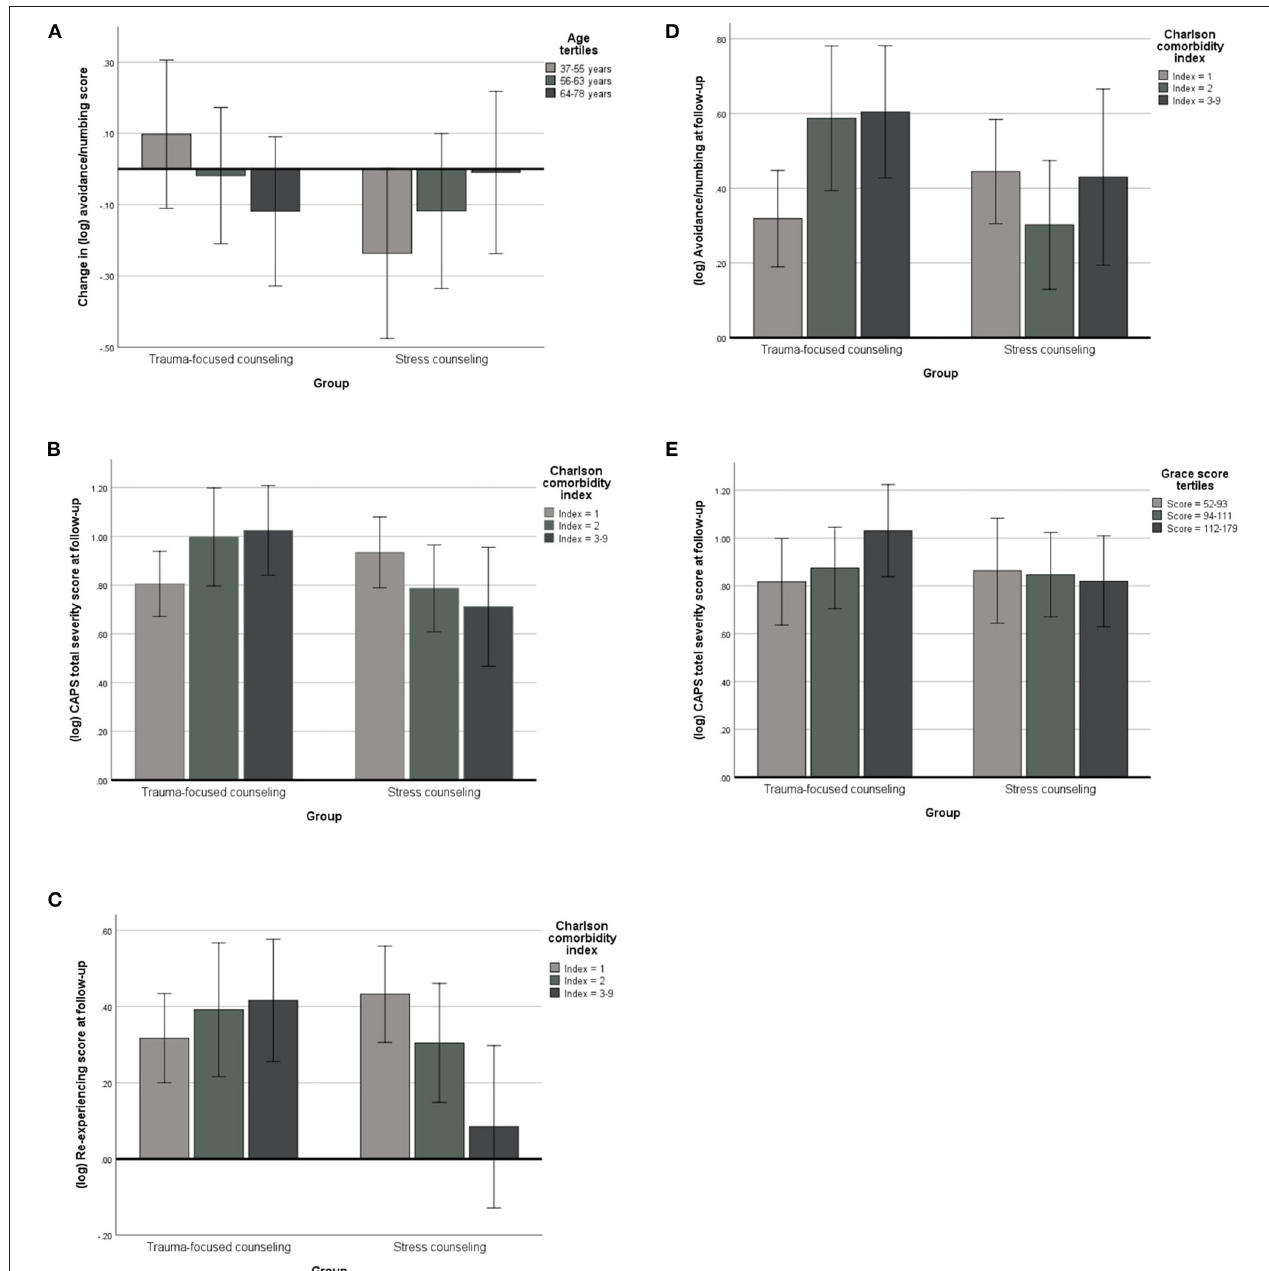
FIGURE 3 | Moderators of intervention effects on post-traumatic stress symptoms. CAPS, Clinician-Administered Post-traumatic Stress Disorder Scale; CAPS scores are expressed as base-10 logarithmically (log) transformed values, which were used in regression models due to a non-normal distribution of original CAPS scores. The bar charts (mean values with 95% confidence interval) illustrate the independent associations between significant moderators of an intervention effect on the change over time from 3- to 12 months in CAPS scores (A) and on CAPS scores across both these follow-ups (B–E) . Adjustments were made for the other variables in the model. These were age, sex, education, Charlson comorbidity index, GRACE score, peritraumatic distress, acute stress disorder symptoms, lifetime depression, and admission post-traumatic stress disorder screen. The mean log value of a CAPS score (y-axis) can be converted back to a base-10 a log mean of 0.1 corresponds to ( ≡ ) a geometric mean of 1.3; 0.2 ≡ 1.6, 0.3 ≡ 2.0, 0.4 ≡ 2.5, 0.5 ≡ 3.2, 0.6 ≡ 4.0, 0.7 ≡ 5.0, 0.8 ≡ 6.3, 0.9 ≡ 7.9, 1.0 ≡ 10.0, 1.1 ≡ 12.6, and 1.2 ≡